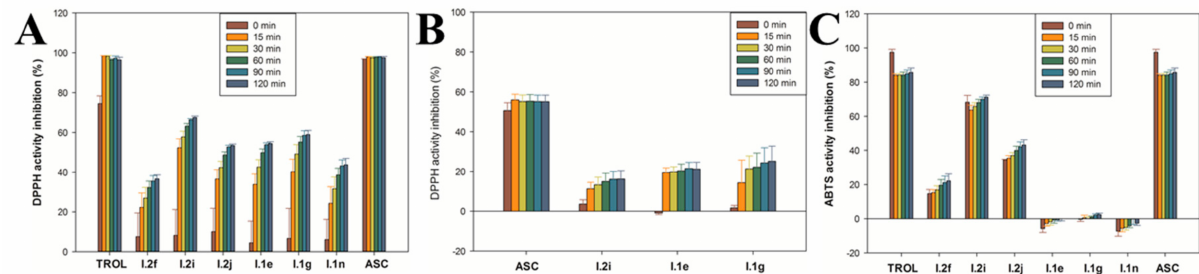
Figure 3. In vitro radical scavenging activity for the most active radical scavengers of series I using the colorimetric assays of DPPH (( A ) for concentrations of 0.03 mg/mL and ( B ) for concentrations of 0.003 mg/mL) and ABTS ( C